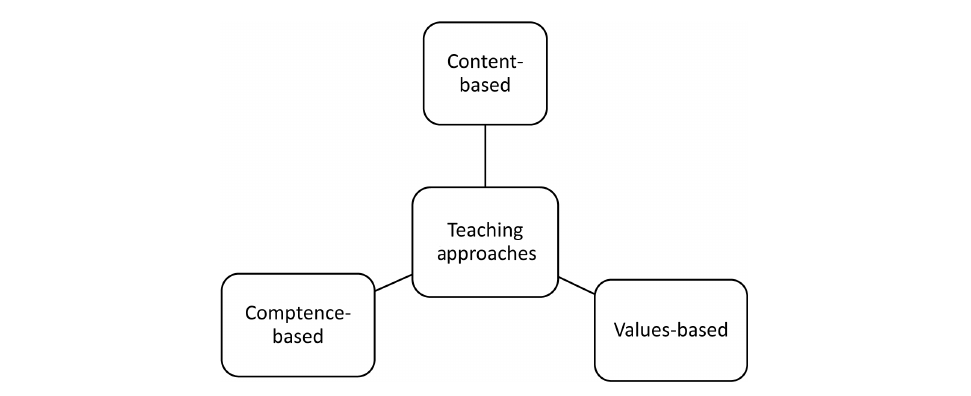
Figure 1: Triumvirate of pedagogical